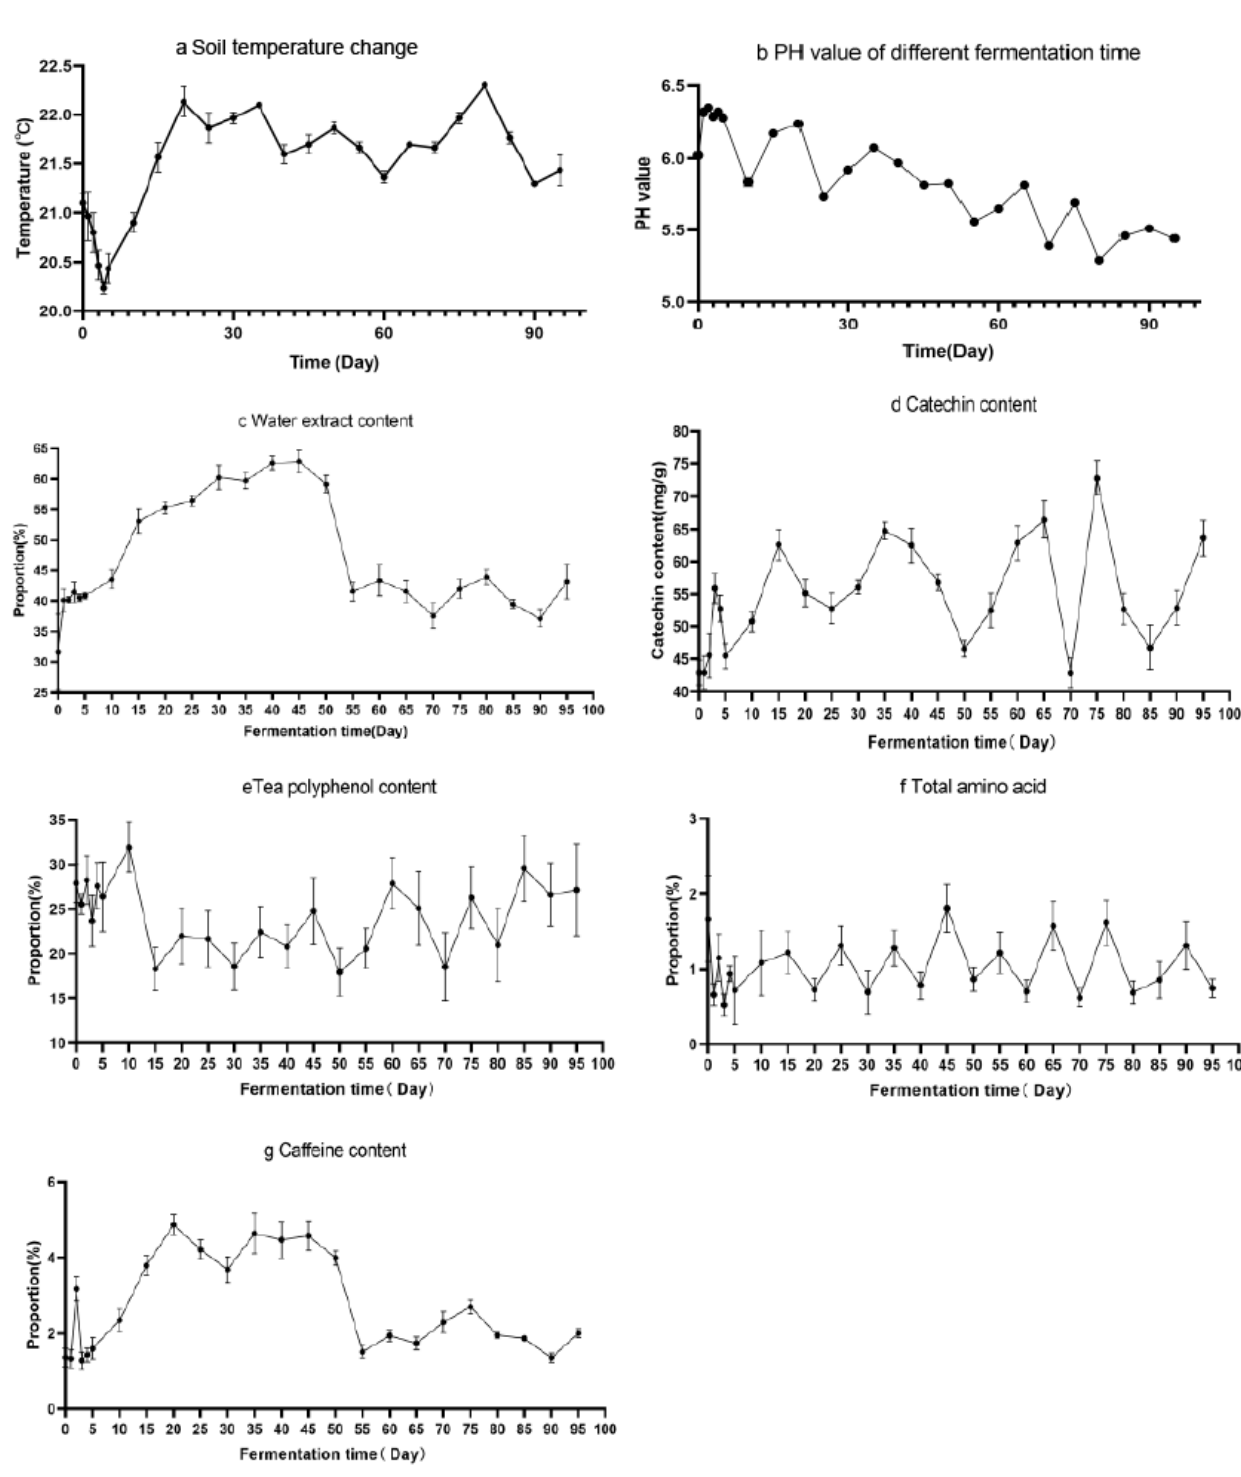
Figure 2. Physiochemical analysis of sour tea ( a ) Changes of soil temperature during fermentation ( b ) pH value changes during the fermentation of sour tea. Contents of the main antioxidant substances in sour tea at different fermentation times. ( c ) The content of water extract in sour tea fermentation. ( d ) The catechin content in sour tea fermentation. ( e ) The tea polyphenol content in sour tea fermentation. ( f ) The total amino acid content in sour tea fermentation. ( g ) The caffeine content in sour tea